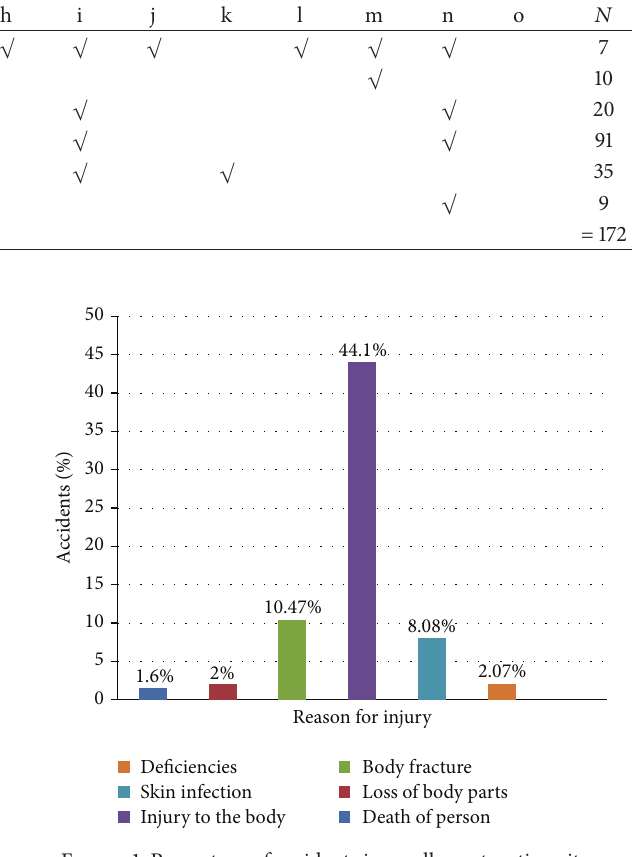
Figure 1: Percentage of accidents in small construction